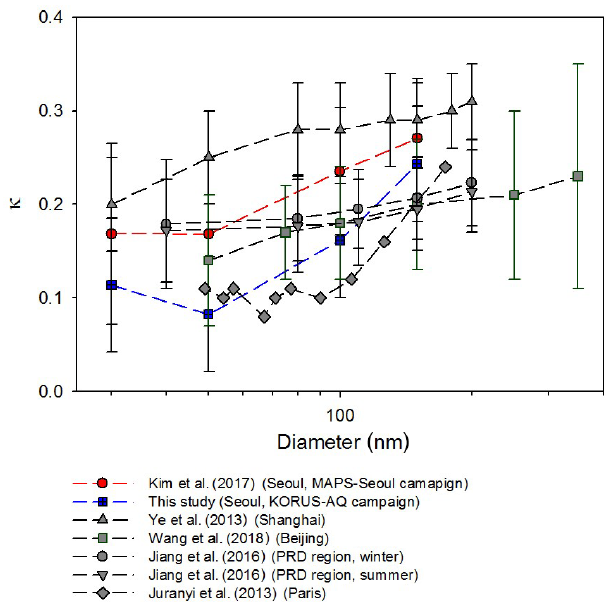
Figure 2. Size-resolved hygroscopicity of aerosols in Seoul and other urban areas.